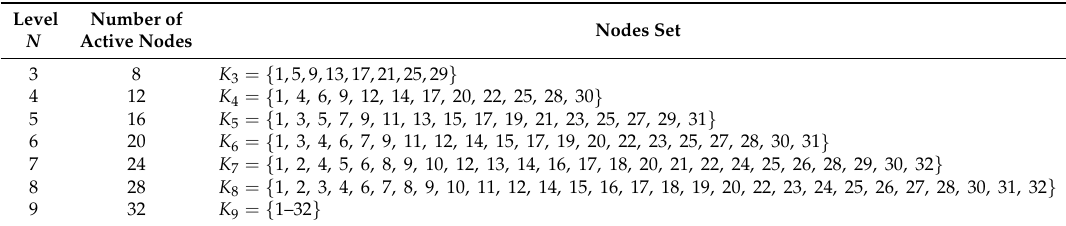
Table 1. Level classification of the WSN with 32